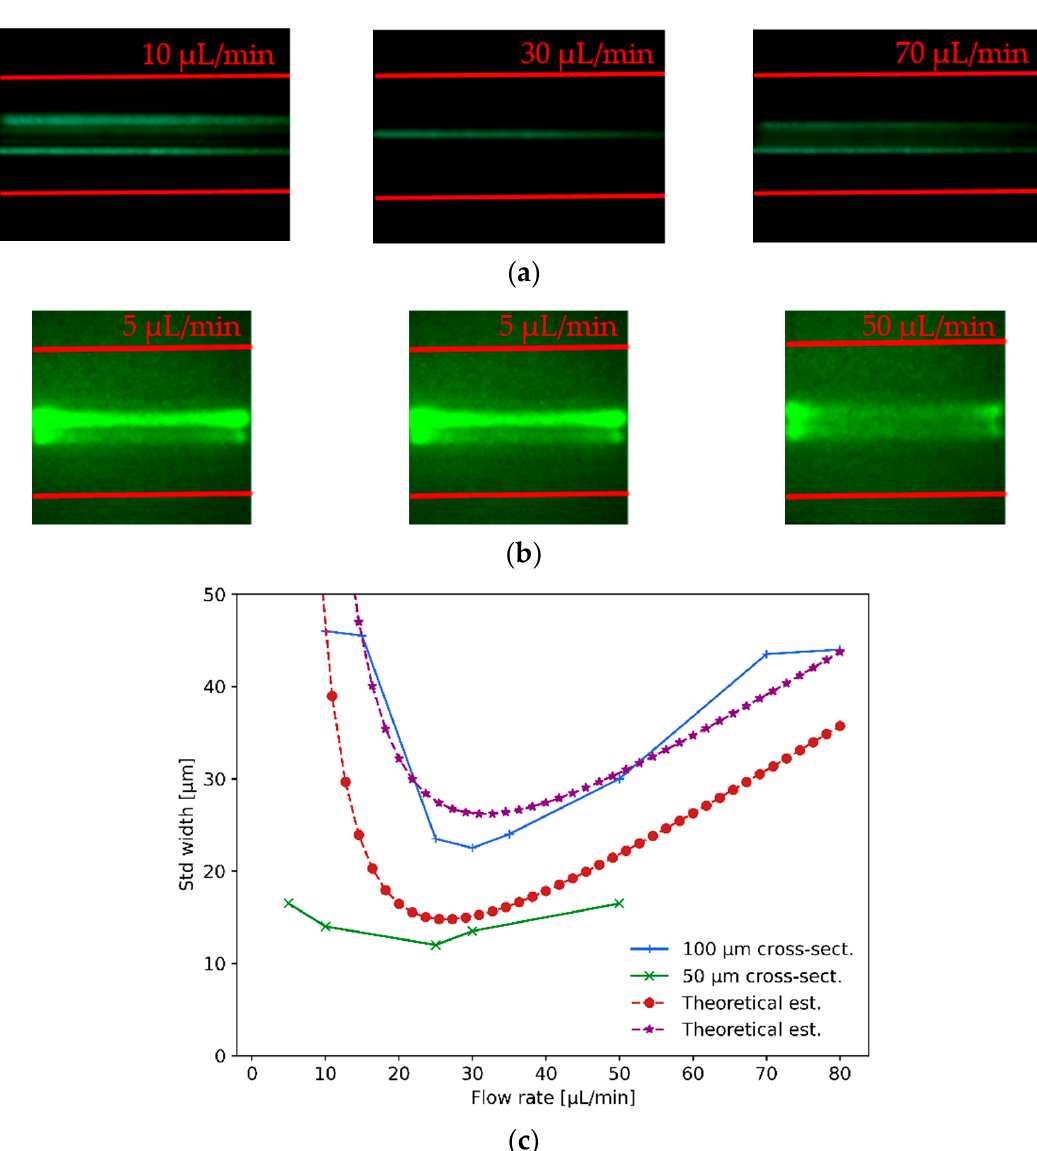
Figure 8. This figure shows 10 µ m and 1 µ m particle visco-elastic hydrodynamic focusing measurements: ( a ) 10 µ m particle hydrodynamic focusing (optimum focusing for ∼ 30 µ L/min) was assessed in a 100 µ m cross-section channel, imaged with a 20 × microscope objective; ( b ) 1 µ m particle hydrodynamic focusing (optimum focusing for 25 µ L/min) was assessed in a 50 µ m cross-section channel, imaged with a 40 × microscope objective. ( c ) For the two different beads sizes, the quality of the hydrodynamic focusing was assessed in terms of the standard deviation width of the particle wake measured and compared to theoretical